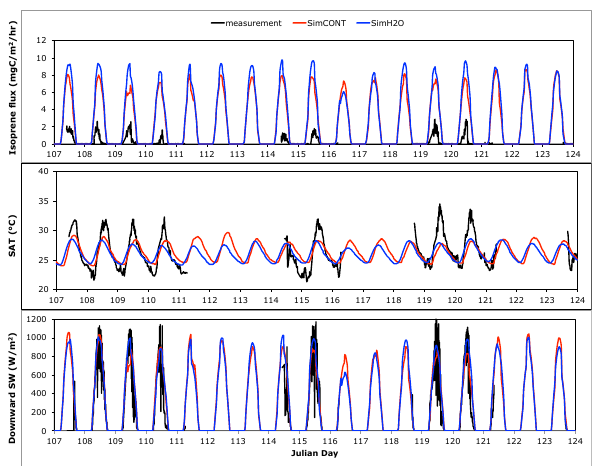
Fig. 7a. (a–f) Time evolution of isoprene emission flux, surface Figure 7. Time evolution of isoprene emission flux, surface air temperature (SAT) and air temperature (SAT) and downward shortwave (SW) radiation at downward shortwave (SW) radiation at the tropical measurement sites. Measurements are shown in black (where data is available). Model climatological results are averages of 10 the tropical measurement sites. Measurements are shown in black simulation years from SimCONT (red) and SimH2O (blue). (a) Results for Costa Rica (where data is available). Model climatological results are averages during April 17-May 4 2003. of 10 simulation years in SimCONT (red) and SimH2O (blue). (a) Costa Rica during 17 April–4 May, 2003.